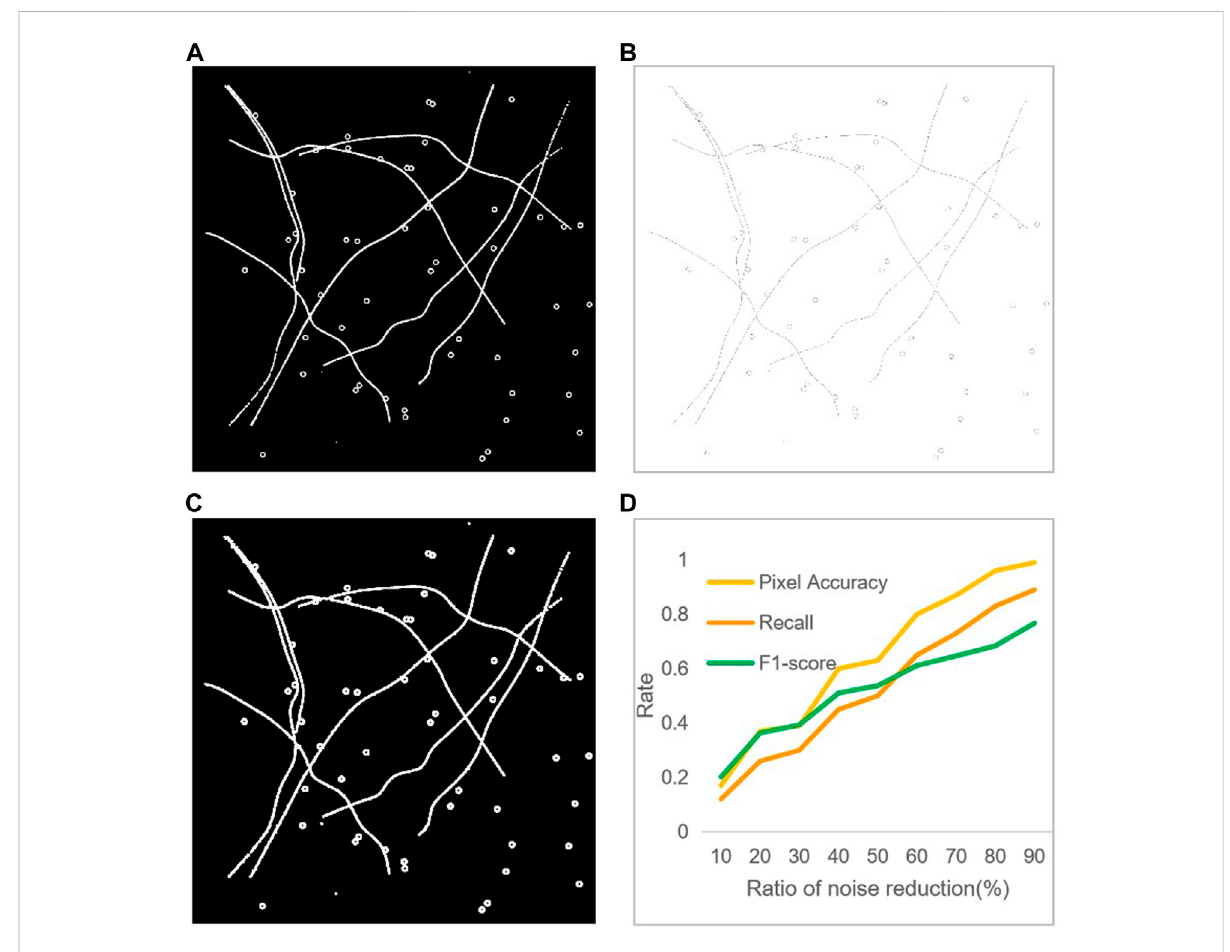
FIGURE 2 Comparison of the different evaluation metric. (A) Raw image. (B) The skeleton image. (C) The groundtruth image, which is the expanded skeleton image. (D) Three evaluation results with different noise reduction